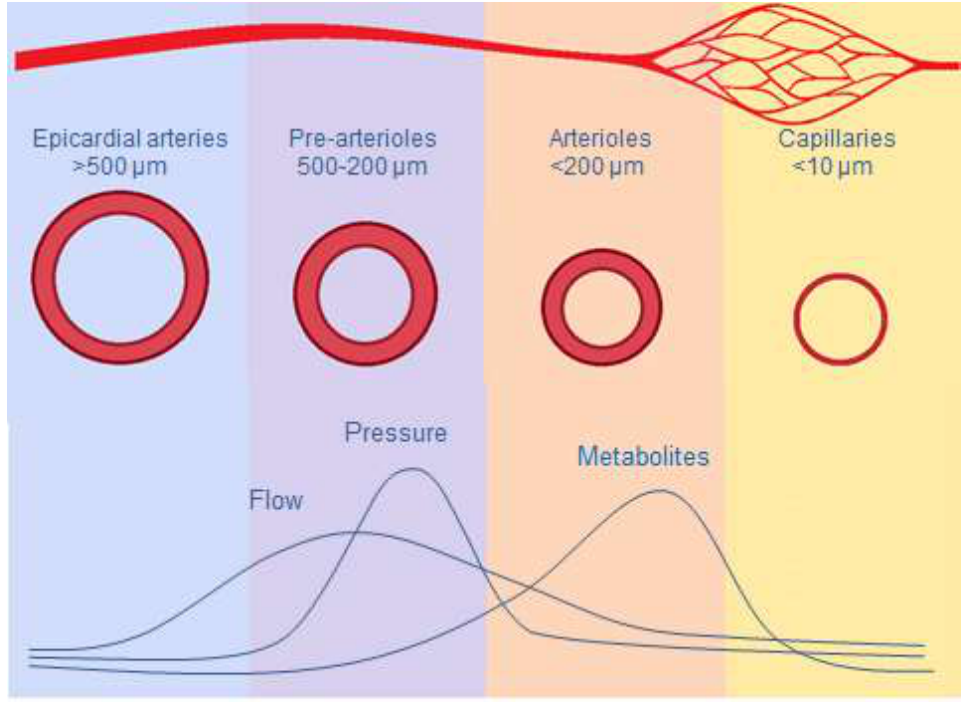
Figure 1. Macro and micro coronary circulation, and mechanisms inducing vasodilatation.